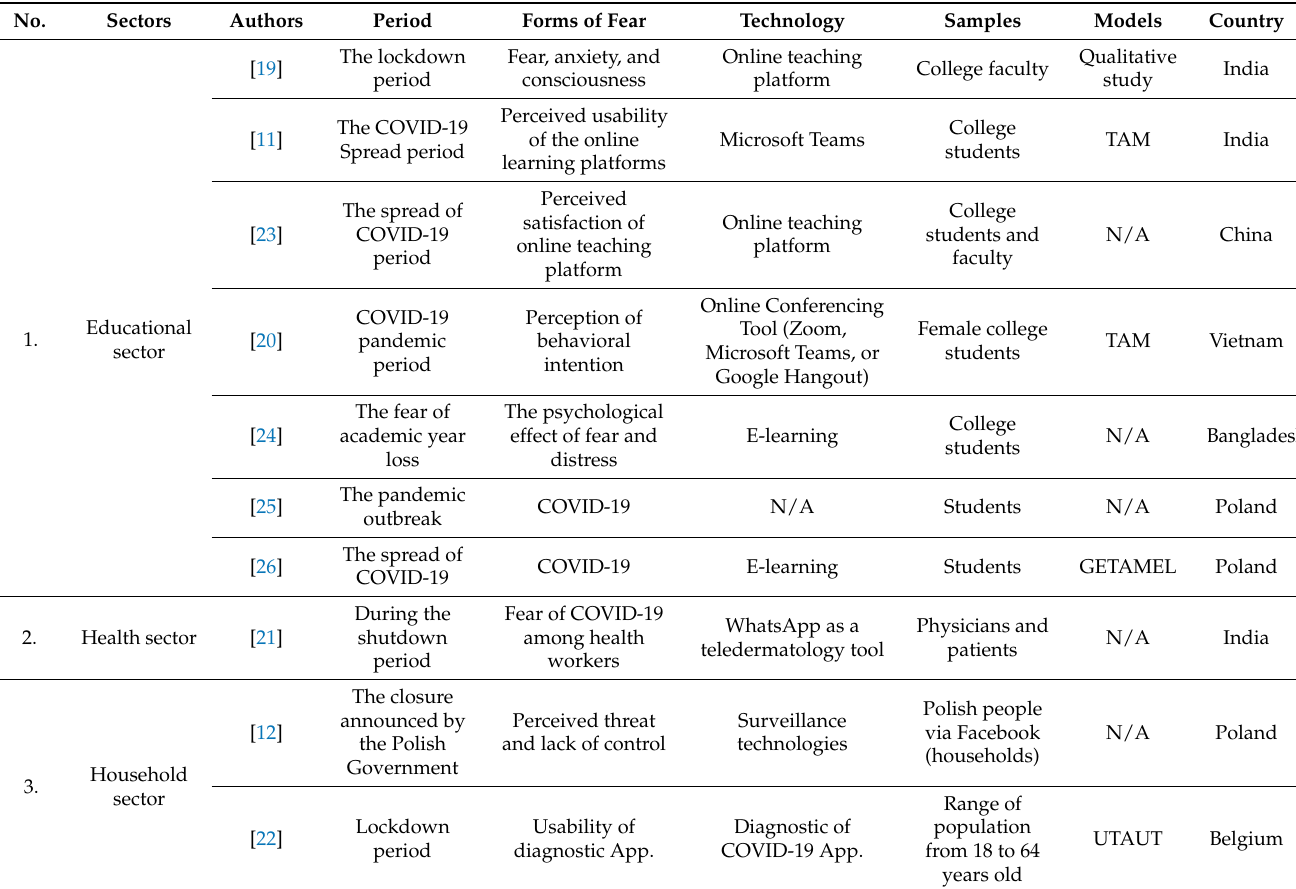
Table 1. Research during the spread of pandemic and lockdown in different